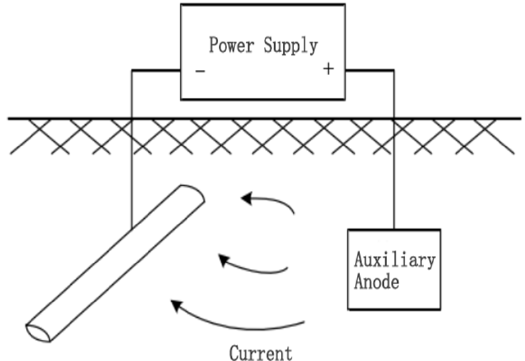
Figure 2. Schematic diagram of the external current protection method.